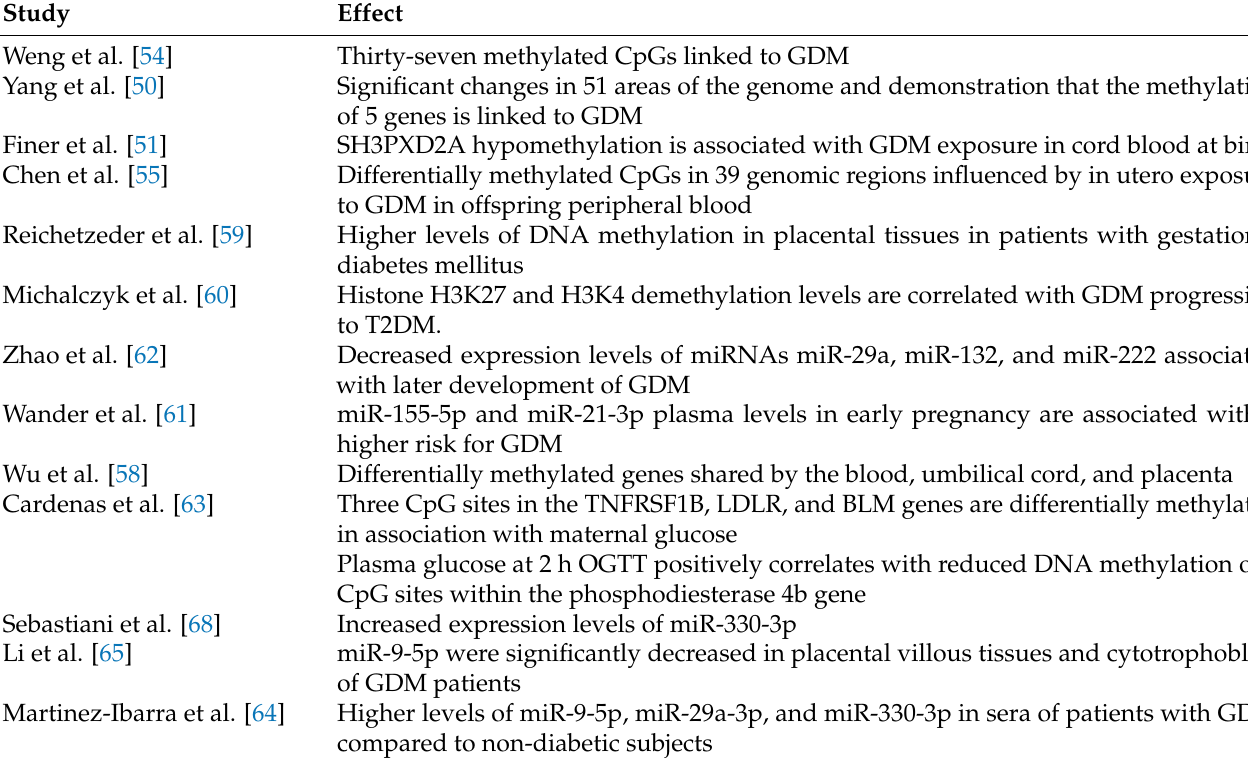
Table 1. Epigenetic studies on gestational diabetes